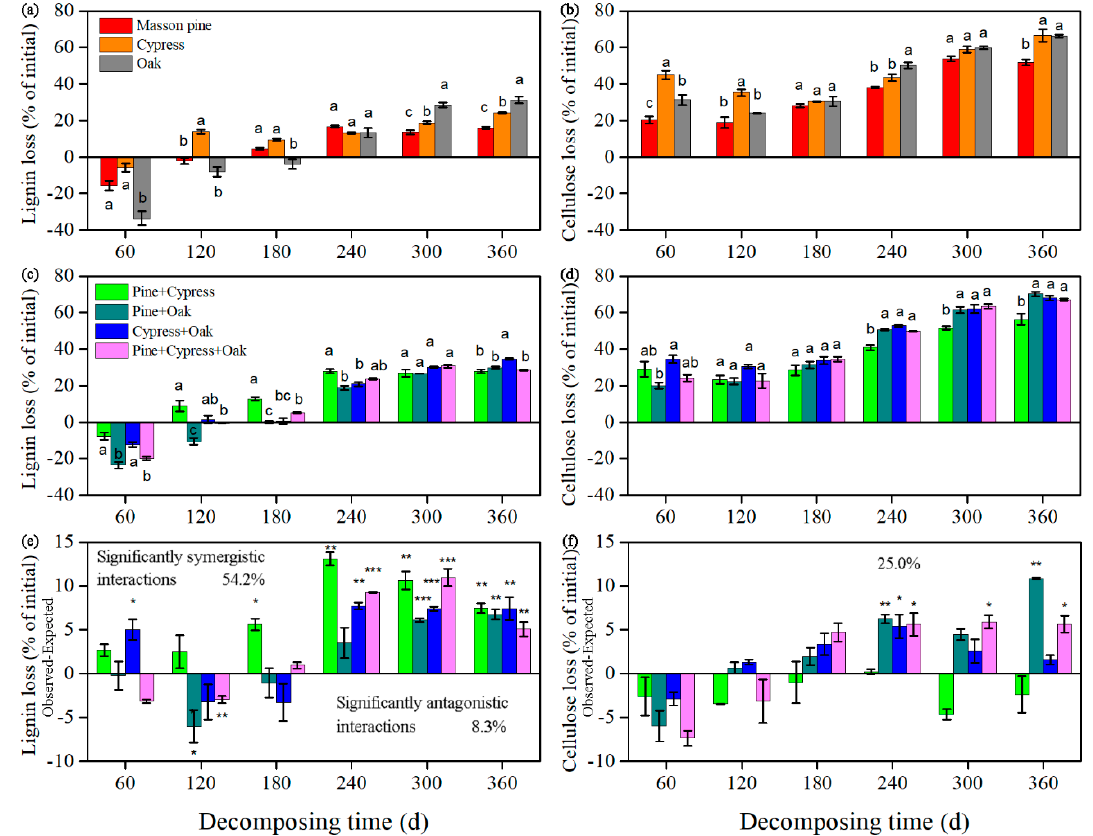
Figure 4. Lignin loss ( a , c ) and cellulose loss ( b , d ) for monospecific and mixed leaf litter of Masson pine ( Pinus massoniana ), cypress ( Cupressus funebris ), and oak ( Quercus variabilis ) during decomposition (mean ± SE, n = 3). Treatments: Pine + Cypress, Pinus massoniana + Cupressus funebris ; Pine + Oak, Pinus massoniana + Quercus variabilis ; and so on. Two-way ANOVA (the litter mixture treatment was treated as a nested factor) indicates significant e ff ects of the litter mixture treatment ( F (6,84) = 29.060 to 44.549, p < 0.001) and decomposition time ( F (35,84) = 75.017 to 134.210, p < 0.001) on the lignin and cellulose loss rates. Di ff erences between the observed and expected values for given variables are shown in ( e ) and ( f ), where a positive value indicates an observed value > the expected value and vice versa. Statistical significance level for comparisons between the observed and expected values: ***, p < 0.001, **, p < 0.01 and *, p < 0.05. Inset values indicate the proportion of the corresponding significant interactions (synergistic and antagonistic interactions lie above and below the zero line, respectively) for a total of 24 cases. Table 1. Regression analyses of changing chemical traits and environmental factors and loss of lignin and cellulose in litter (%, per phase) of the single-species treatments (A) and mixtures (B). Cellulose Average Temperature